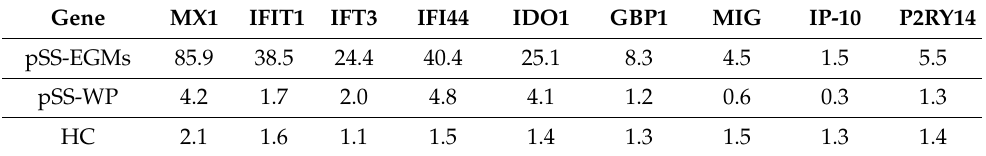
Table 1. Fold change values of gene expression in patients with primary Sjögren Syndrome (pSS) plus extraglandular manifestations (EGMs)- pSS-EGMs, in patients with disease limited to glandular involvement (GI) plus widespread pain (WP)-pSS-WP, and in healthy controls (HCs). Gene MX1 IFIT1 IFT3 IFI44 IDO1 GBP1 MIG IP-10 P2RY14 pSS-EGMs 85.9 38.5 24.4 40.4 25.1 8.3 4.5 1.5 5.5 pSS-WP 4.2 1.7 2.0 4.8 4.1 1.2 0.6 0.3 1.3 HC 2.1 1.6 1.1 1.3